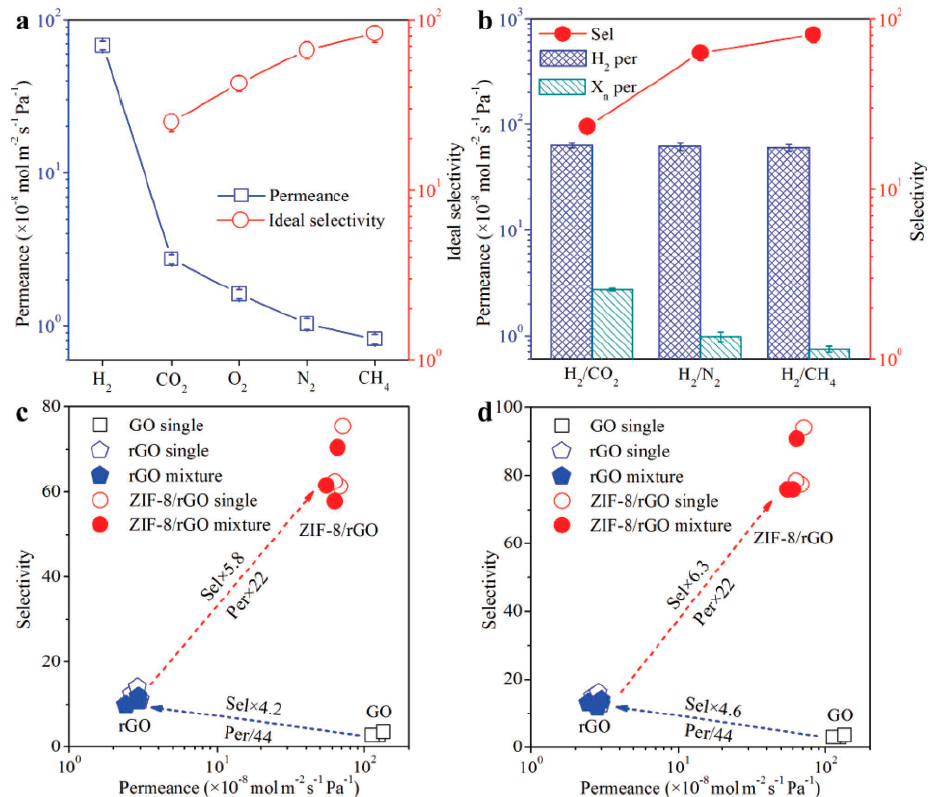
Figure 21. ( a ) The permeation properties of various gases through the ZIF-8/rGO membrane. ( b ) The separation performance of the ZIF-8/rGO membrane for H 2 /CO 2 , H 2 /N 2 , and H 2 /CH 4 mixtures. The comparison of the GO, rGO, and ZIF-8/rGO membranes for ( c ) H 2 /N 2 and ( d ) H 2 /CH 4 separations. (adapted with permission from ref. [122]).